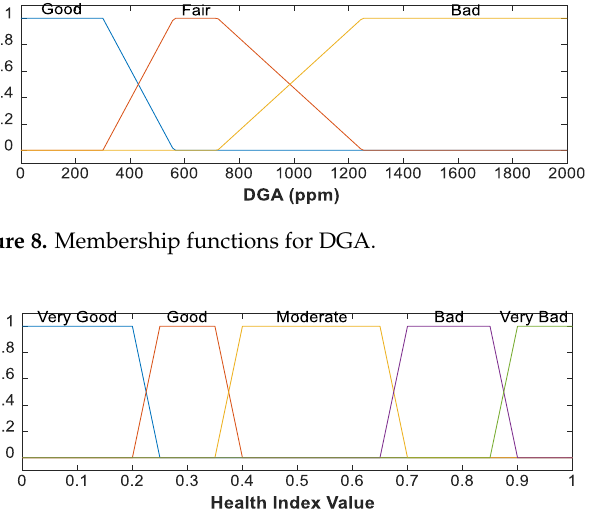
Figure 9. Membership functions for the final HI.